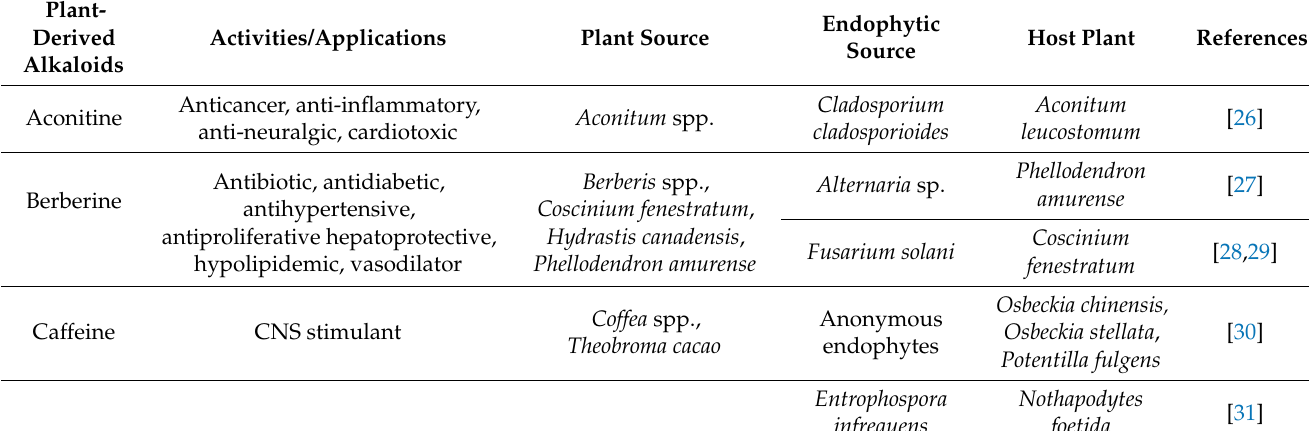
Table 1. Plant-derived alkaloids produced by endophytic